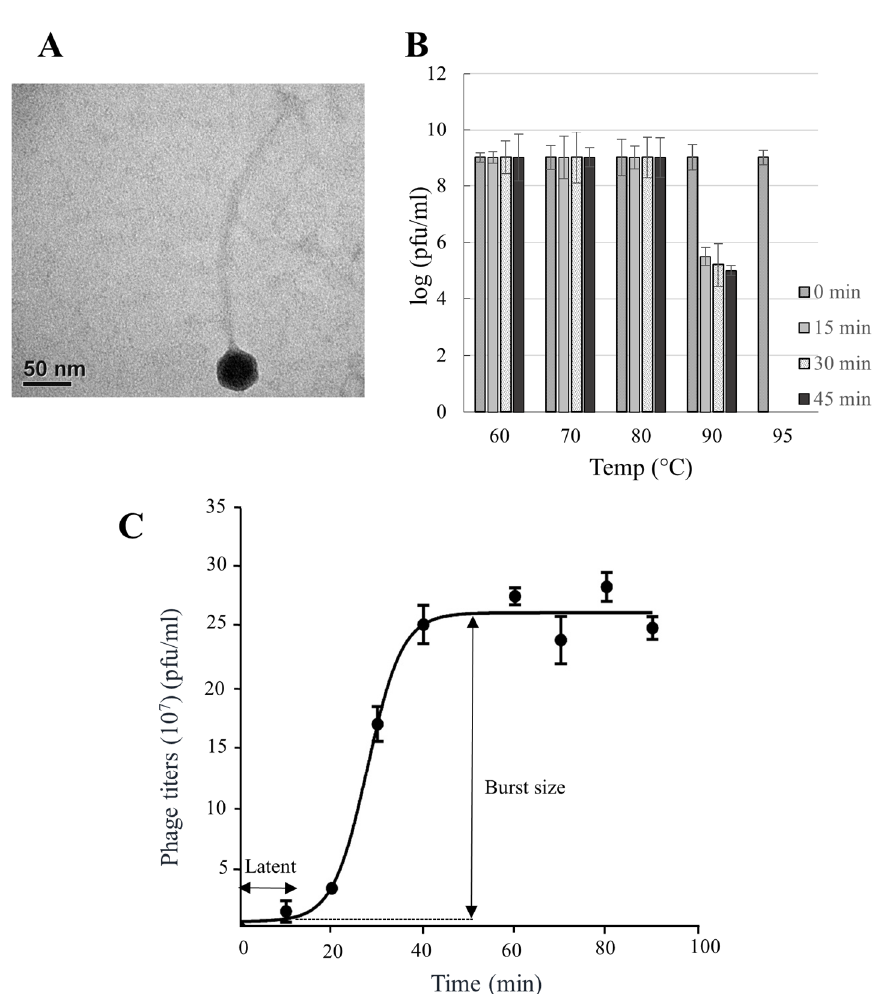
Figure 2. Morphology and infectivity of P318. ( A ) Virions of P318 observed under the transmission electron microscope at 400,000 × magnification. ( B ) Thermal stability of P318 virions showing indicated temperatures at di ff erent time periods (0, 15, 30, and 45 min). The phage titer was determined by the double-layer agar plate assay. Values are the means of three determinations with ± SD. ( C ) One-step growth cycle of P318. Infection of T. fusca by P318 was initiated at the condition of 0.001 MOI at 50 ◦ C. The latent period and burst size of P318 were determined from the growth curve. The error bar represents the standard deviation of three independent